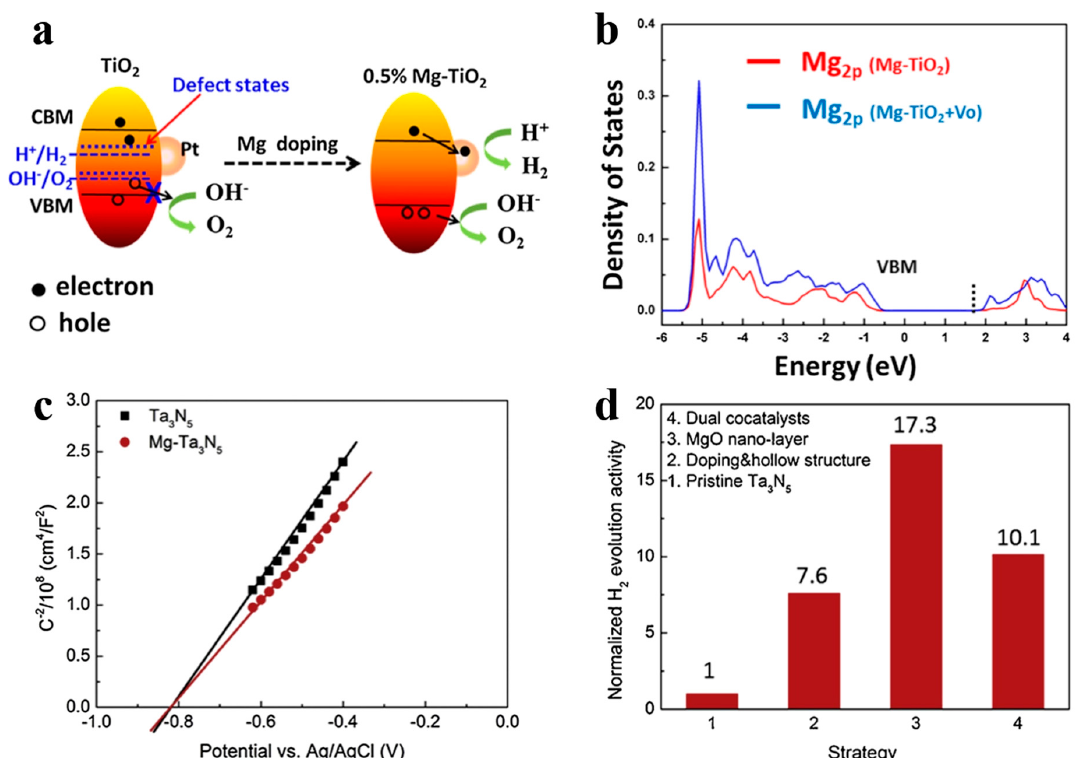
Figure 7. ( a ) Schematic illustration of the band structure of anatase TiO 2 with and without Mg doping for water splitting. ( b ) The density of states of Mg 2p in different samples. Reproduced with permission from [61]. Copyright Elsevier, 2017. ( c ) Mott–Schottky plot of Ta 3 N 5 with and without Mg dopant in dark, and ( d ) normalization of the contribution of individual strategy to the photocatalytic activity. Reproduced with permission from [62]. Copyright Elsevier, 2019.